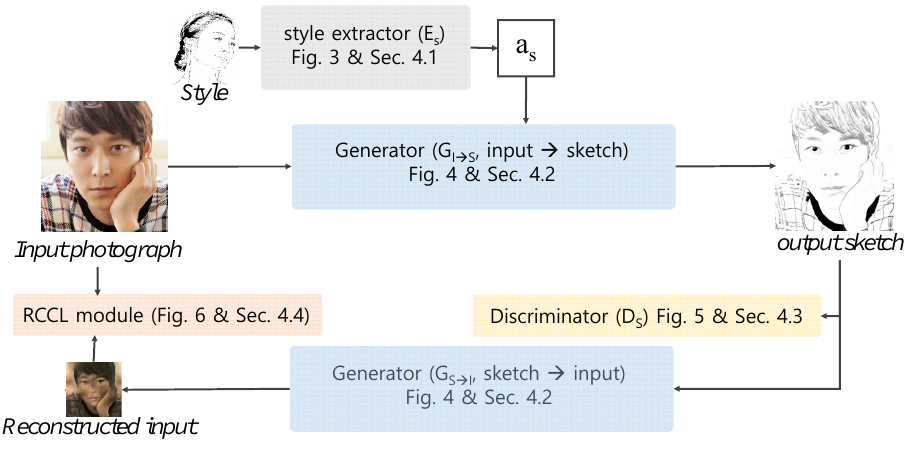
Figure 2. The process of our framework.